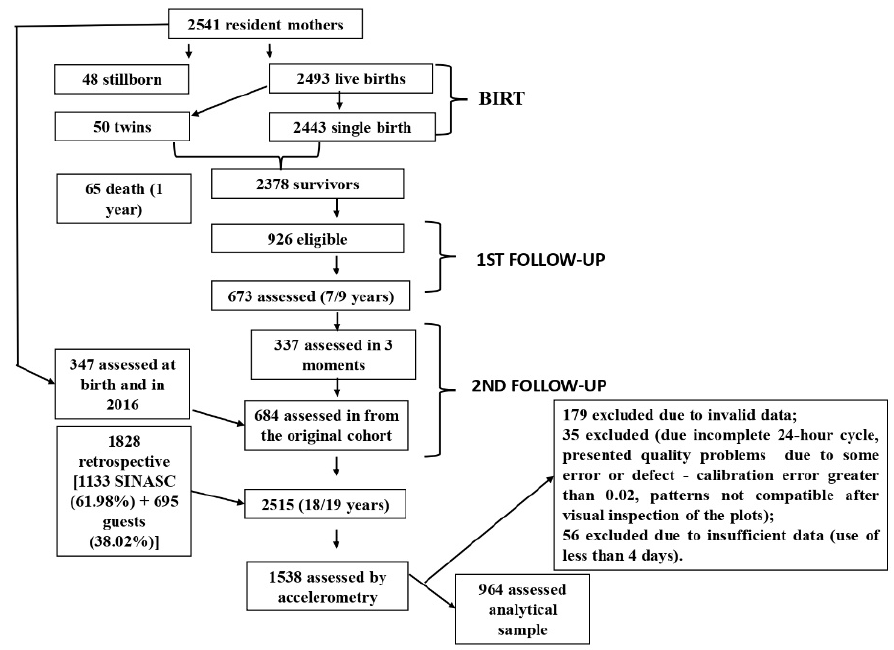
Figure 1. Flowchart of the 1997/1998 birth cohort of São Luís, Maranhão, Brazil.